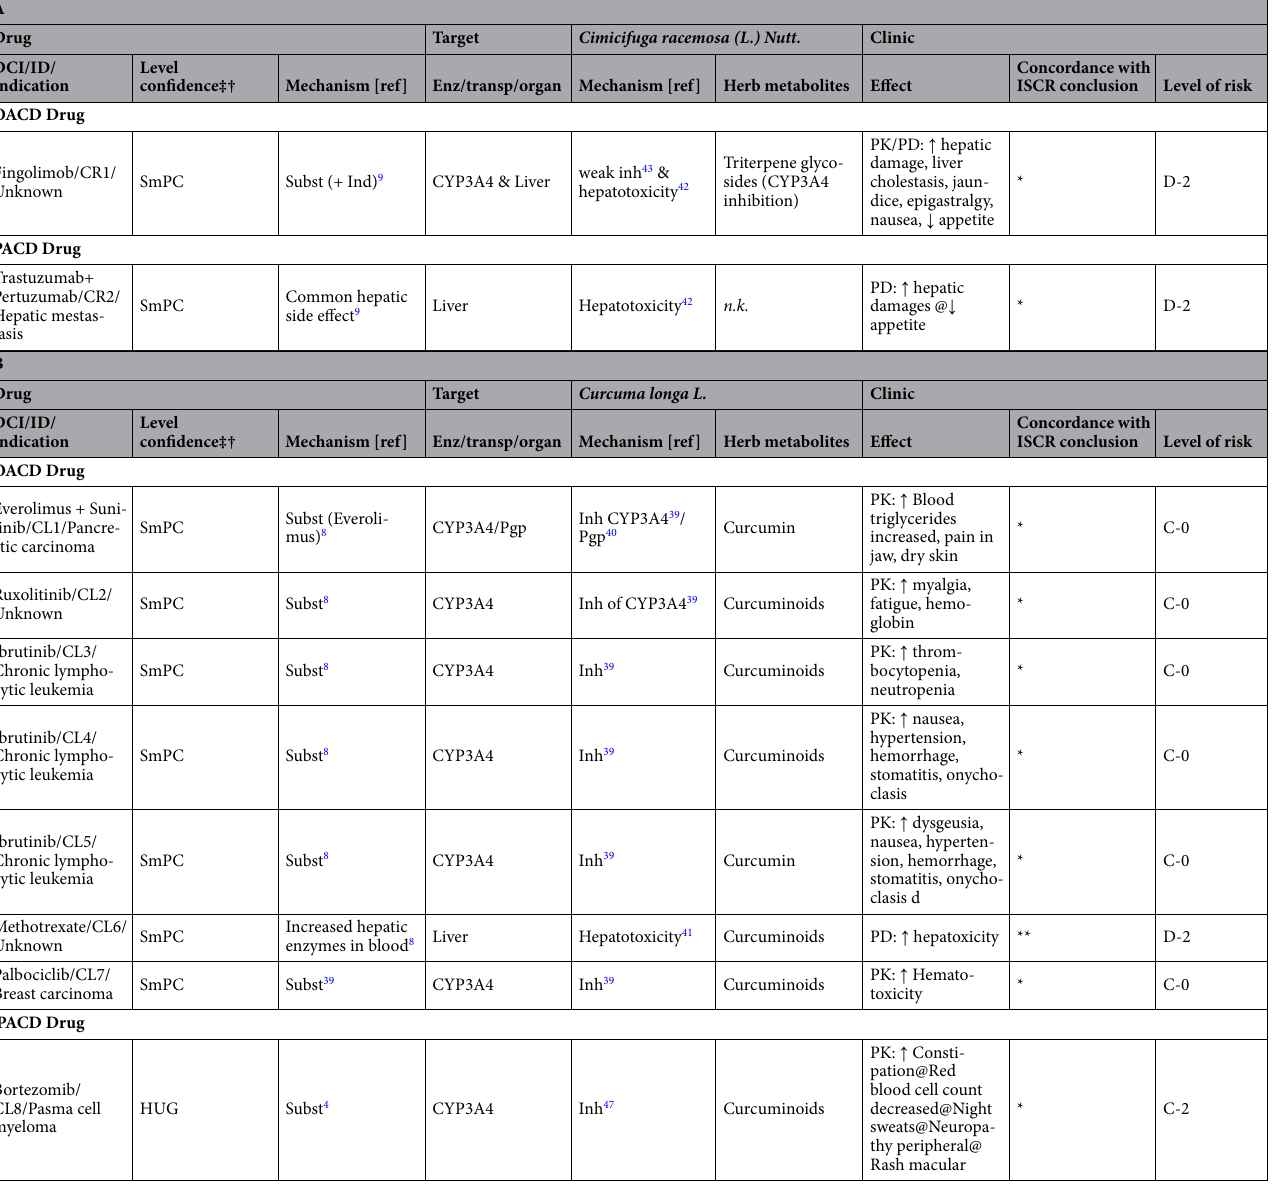
Table 3. (A) Cimicifuga racemosa L. & (B) Curcuma longa L.—ACD interactions among selected ICSRs. OACD: Oral Anti-Cancer Drug; PACD: Parenteral Anti-Cancer Drug; PK: pharmacokinetic;